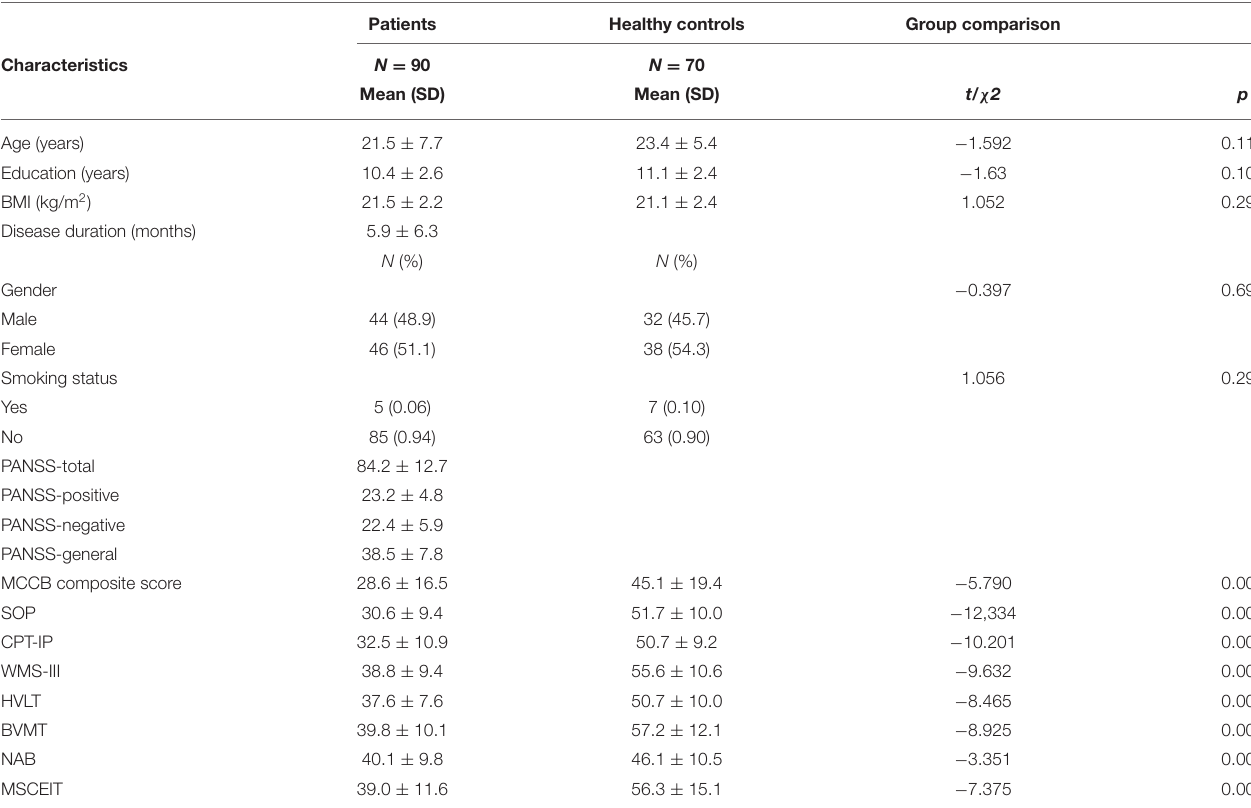
TABLE 1 | Demographic and clinical characteristics of the study sample. Patients Healthy controls Group comparison